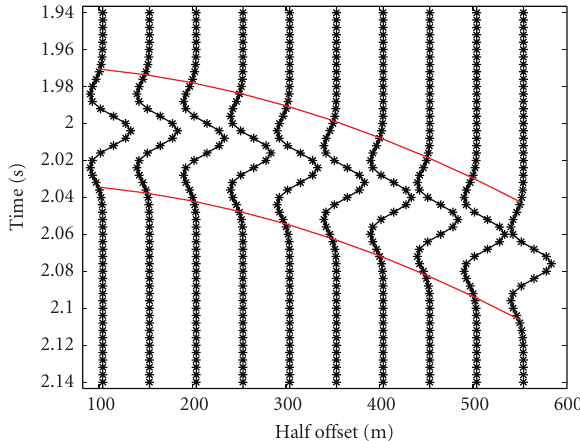
Figure 3: Synthetic CMP data used for comparison of MUSIC with semblance. A point di ff ractor and a dipping reflector ( β = 20 0 ) with the same τ 0 = 2sec is used to generate the data. Note that the two events are very close to each other and it is di ffi cult to distinguish them.